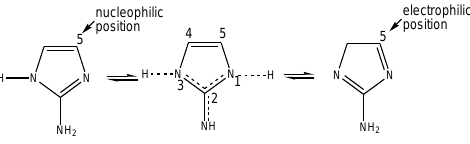
Figure 7. The tautomerism and ambivalent reactivity of 2-amino-imidazole (as decribed by Al-Mourabit and Potier, 2001) The 2-amino-imidazole building block possesses tautomeric property which is important for the molecular diversity of pyrrole-imidazole alkaloids (Figure